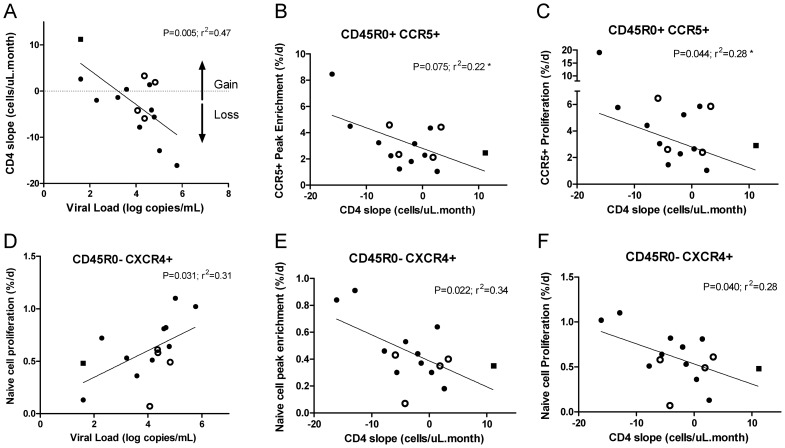
Correlates of CD4 cell loss in HIV-infected subjects.Relationship of CD4 slope with viral load in all HIV-infected subjects (A); each symbol represents a single subject; closed circles, R5-tropic subjects; open symbols, X4-tropic subjects; closed square, treated subject (RH07R); undetectable viral load was attributed the value of 40 copies/mL (the detection threshold), or 1.6 as log10. CD4 cell loss was expressed as a rate of decline in the months preceding in vivo kinetic studies. Relationship of viral load and CD4 slope with kinetic parameters in memory (CD45R0+CCR5+) (B, C) and naïve (CD45R0−CXCR4+) (D, E, F) CD4+ T-cells; symbols as frame (A); analysis by Pearson linear regression, * log transformed for skewed CCR5+ data.